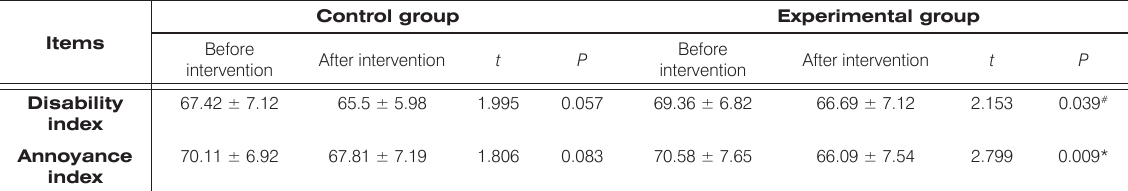
Table 2. Blood glucose and blood lipid changes (M ± SD, n = 59)